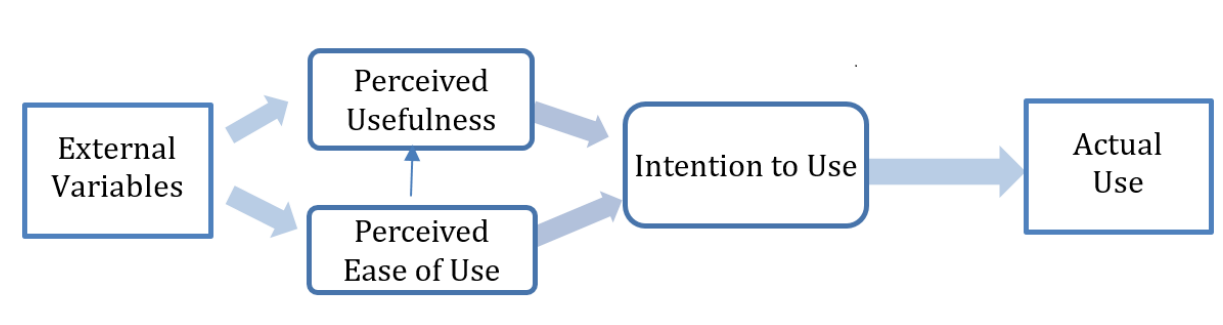
Figure 3. Simplified Technology Acceptance Model